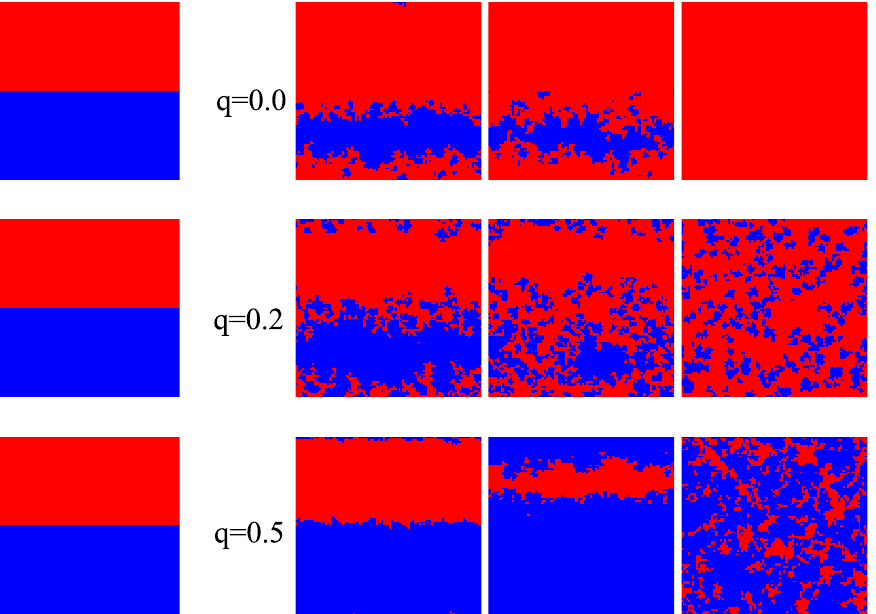
Figure 3. Characteristic snapshots of cooperators and defectors on the lattice for different values of information acquisition probability q . The only difference from Figure 2 is the initial distribution of cooperators and defectors. Here, cooperators are arranged in the upper part of the whole lattice, but the defectors occupy the lower part of the lattice. All other setup and model parameters are identical to those in Figure